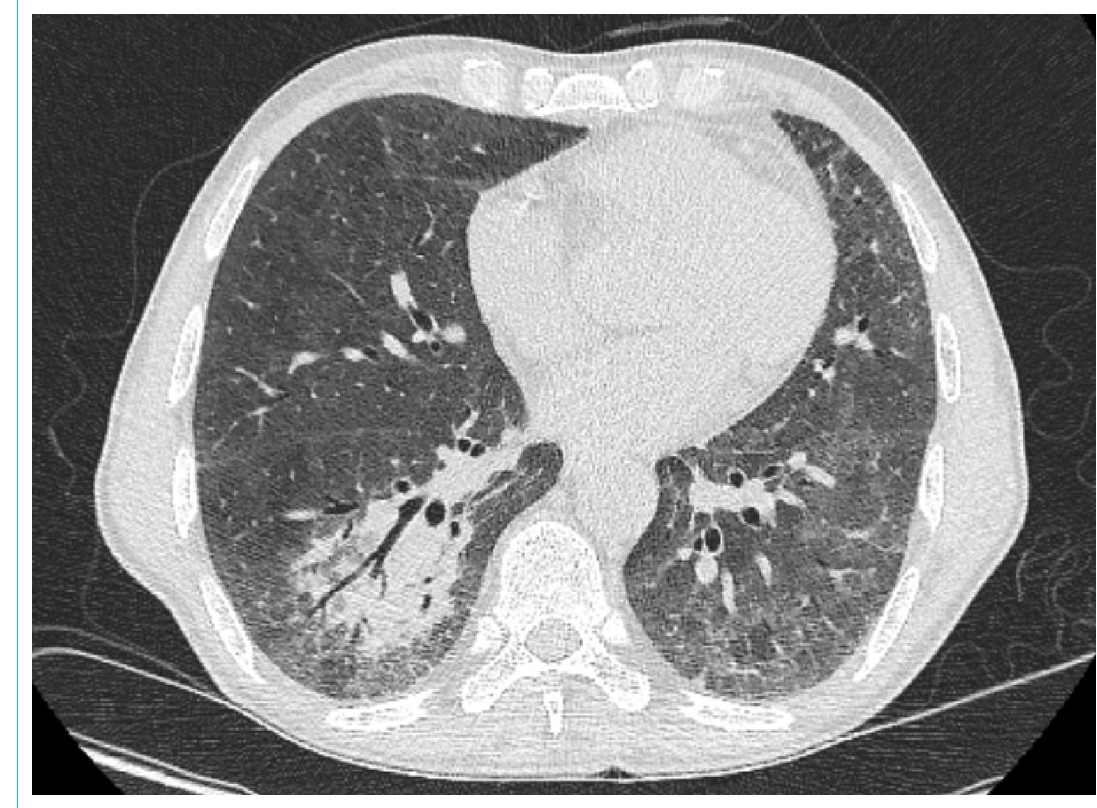
Figure 1: Chest computed tomography on day 3 of admission showing a right lower lobe consolidation with air